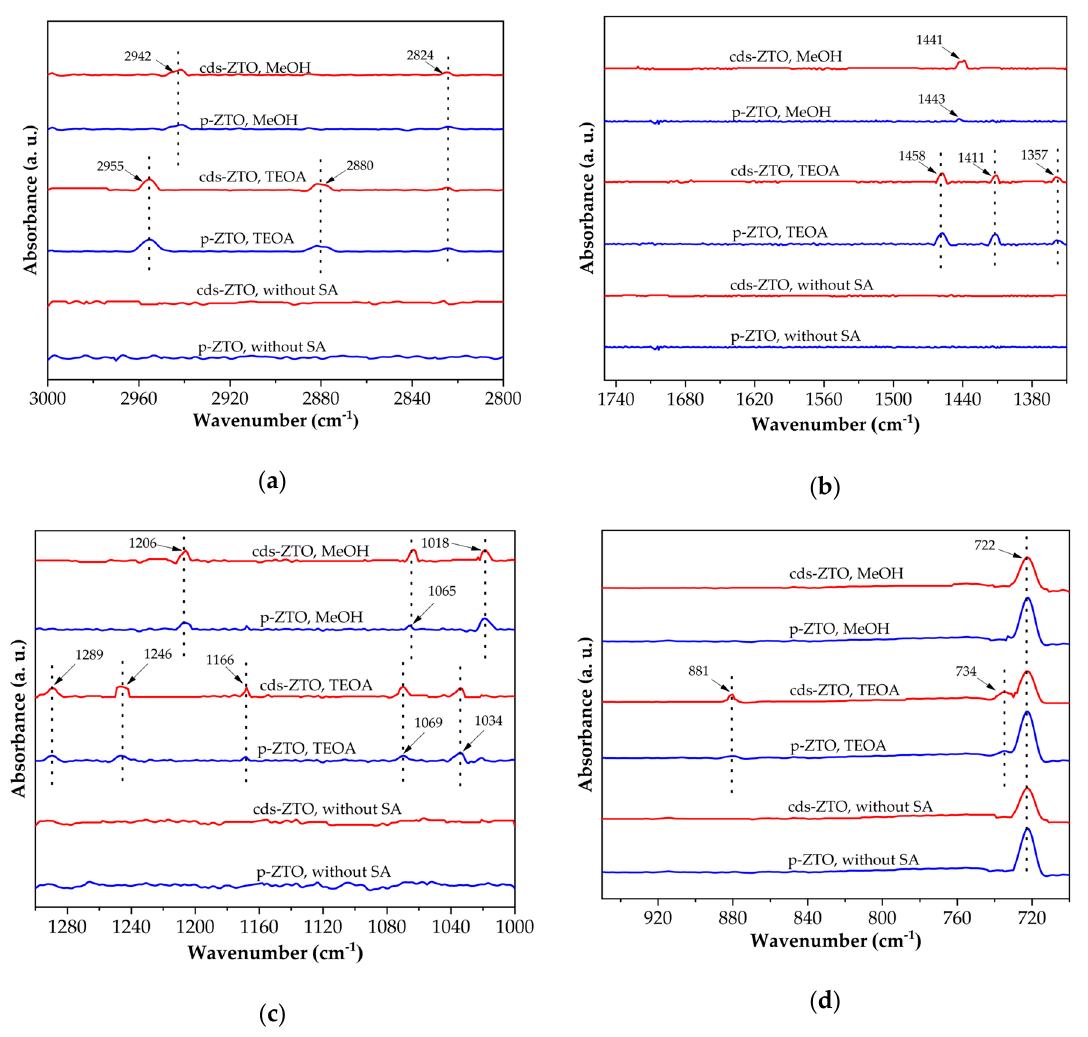
Figure 12. FT-IR spectra of cds-ZTO and p-ZTO before and after the adsorption of methanol and triethanolamine as sacrificial agents. Regions: ( a ) 3000–2800 cm − 1 , ( b ) 1750–1350 cm − 1 , ( c ) 1300–1000 cm − 1 , and ( d ) 950–700 cm − 1 (SA = sacrificial agent).